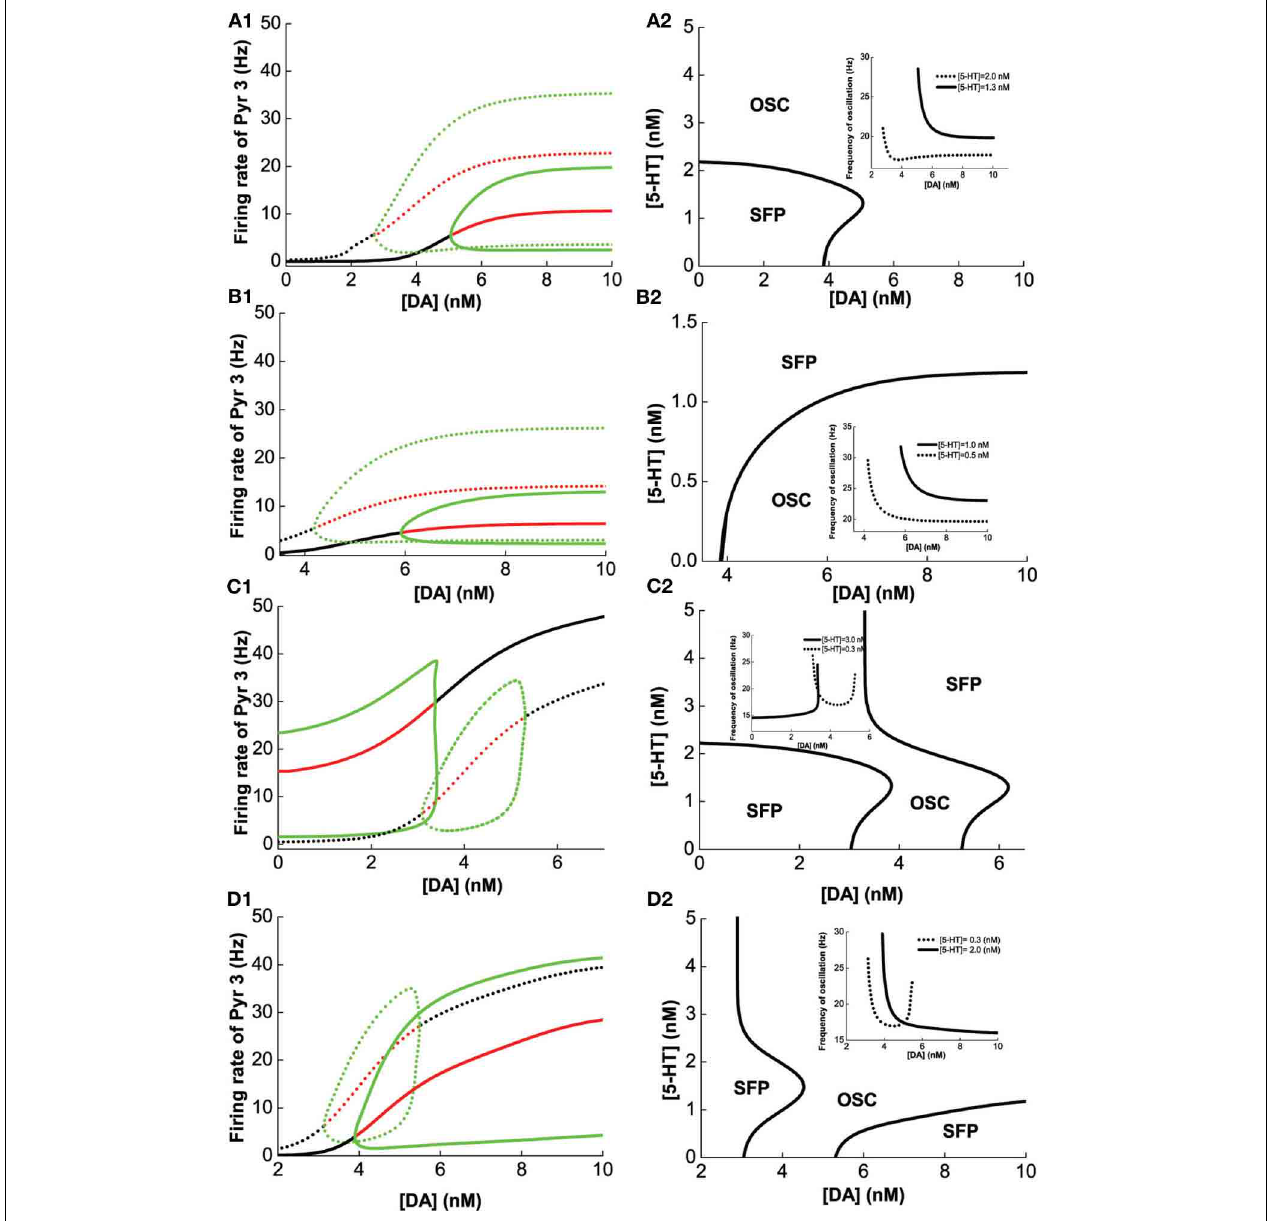
FIGURE 6 | Modulation of [DA] and [5- HT ] on excitatory-inhibitory neuronal networks. Pyr3 (D1 + 5-HT1A + 5-HT2A)neurons paired with: (A) Int1 (D1 + 5-1HT1A), (B) Int2 (D1 + 5-HT2A), (C) Int3 (D2 + 5-HT1A), (D) Int4